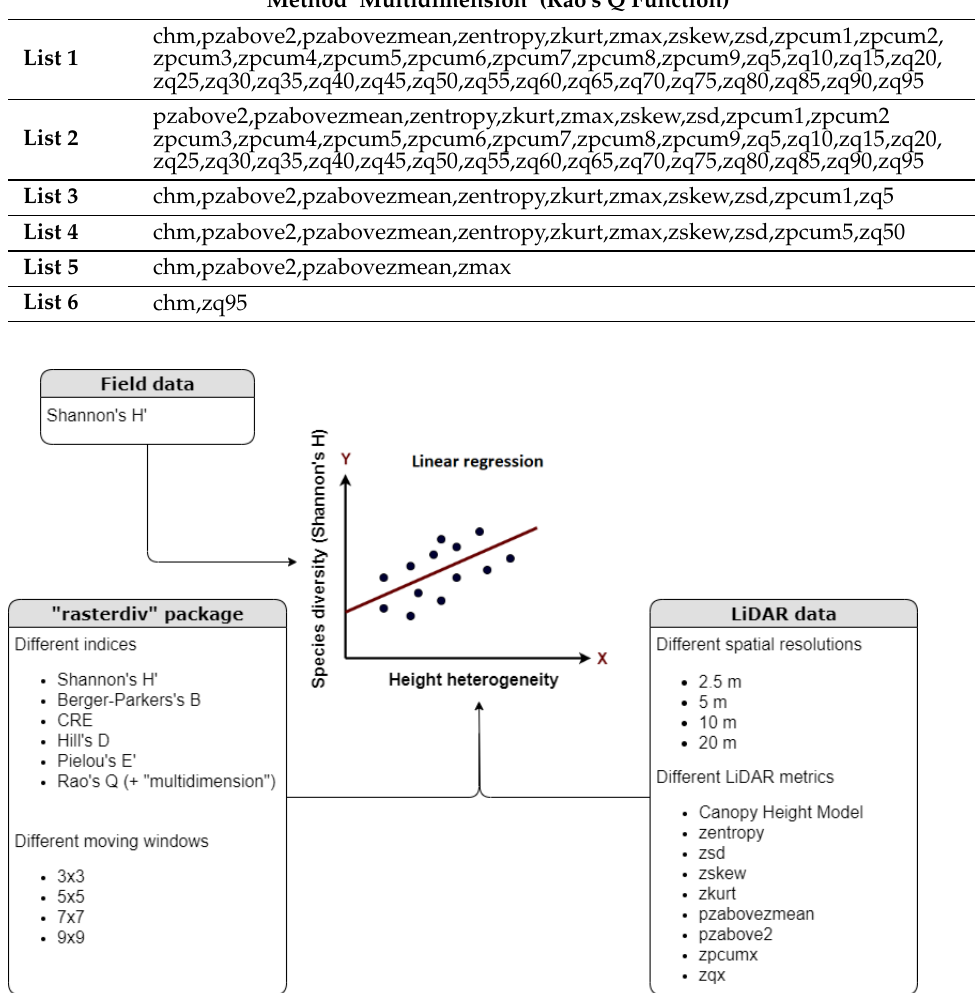
Figure 2. Summary scheme of the used methodology. The height heterogeneity (HH), has been calculated for each plot, testing different LiDAR metrics at different spatial resolution using various heterogeneity indices (with different moving windows) of the R rasterdiv package. The HH has been successively related by linear regression with the tree species diversity (Shannon’s H) of each plot.